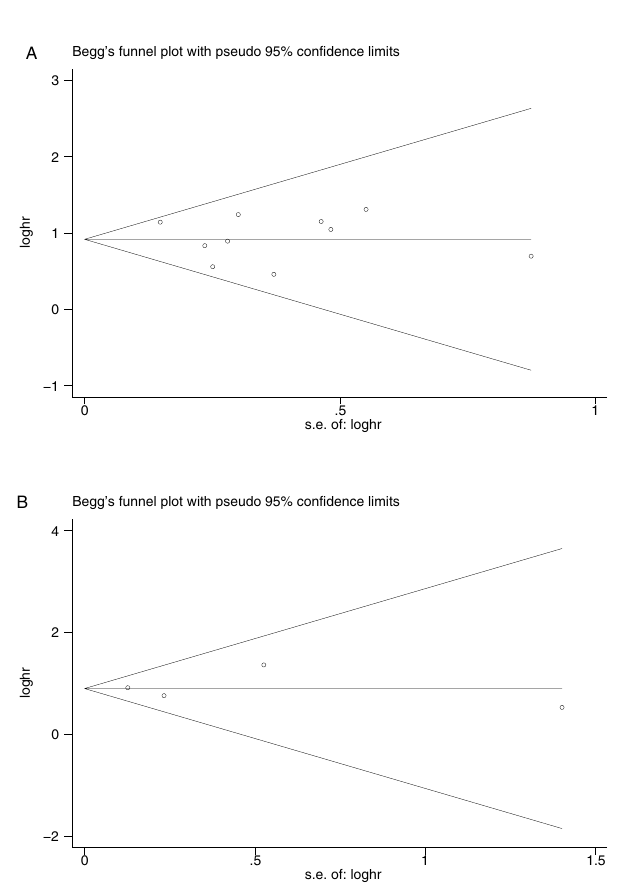
Figure 3. The correlation between CD146 expression and time to progression (TTP) in solid tumors.